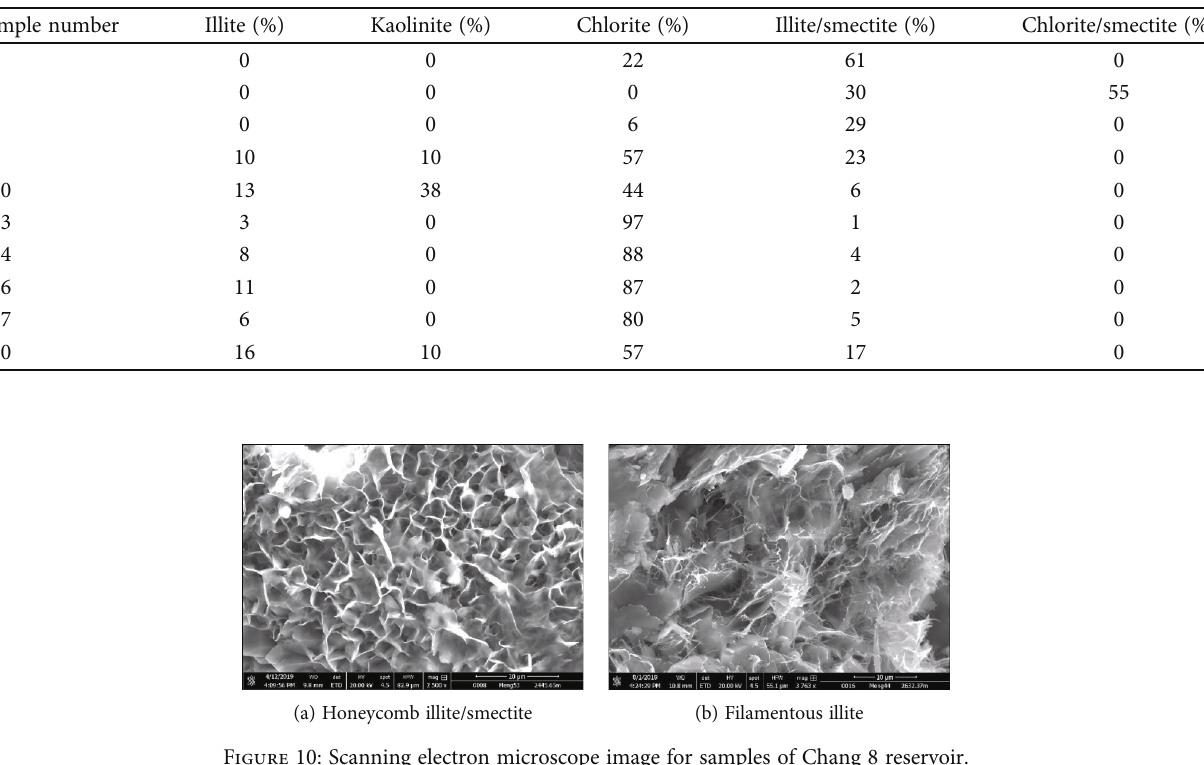
Figure 9: The average relative content of di ff erent clay minerals. Table 2: Clay mineral analysis results of the Chang 8 member in Pengyang area.